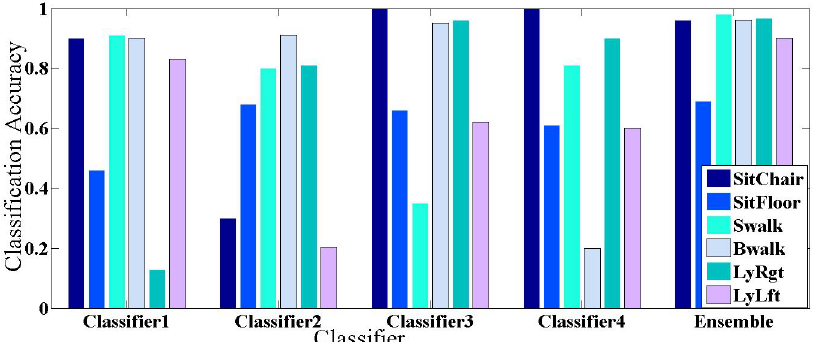
Figure 10. Classification accuracy (activity wise) for device independent activity recognition with D5 as test device using condition-based and ensemble classifiers for accelerometer